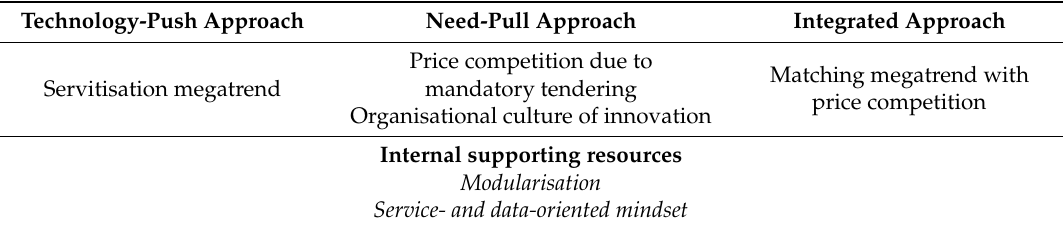
Table 3. Summary of the adoption drivers for Aebi